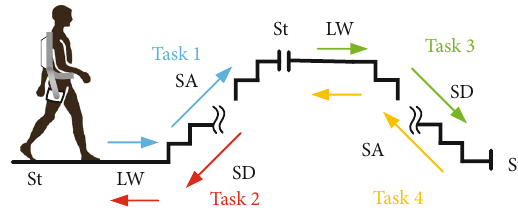
Figure 2: The tasks in the experiments. St denotes standing, LW is short for level walking, SA is short for stair ascending, and SD is short for stair descending. The arrows indicate ambulation direction. The tasks are denoted with di ff erent